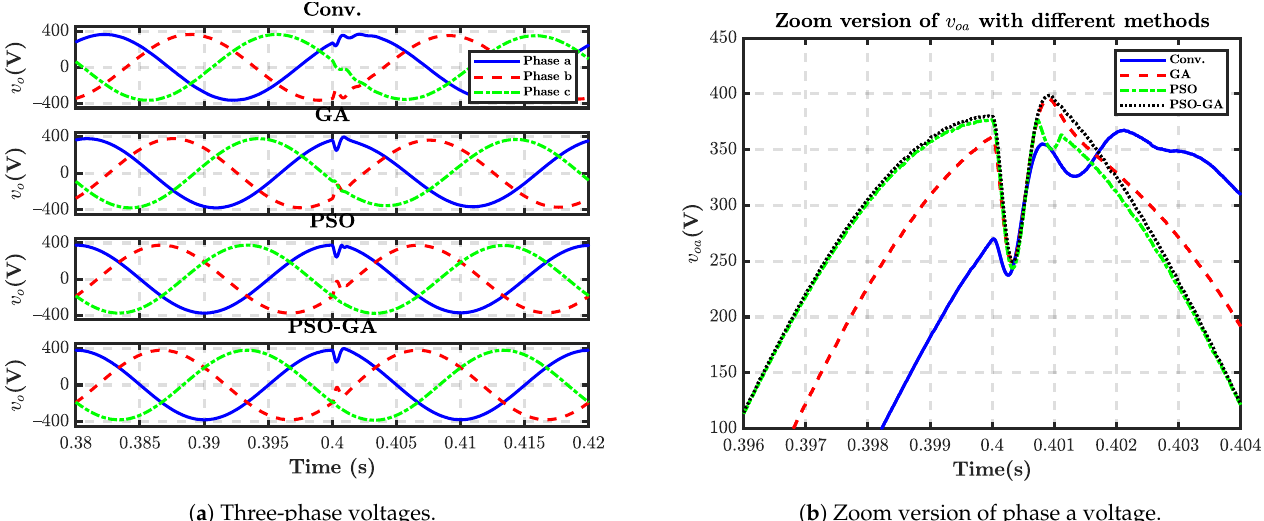
Figure 18. Three-phase voltages and phase a voltage of the MG common bus with different de- signed